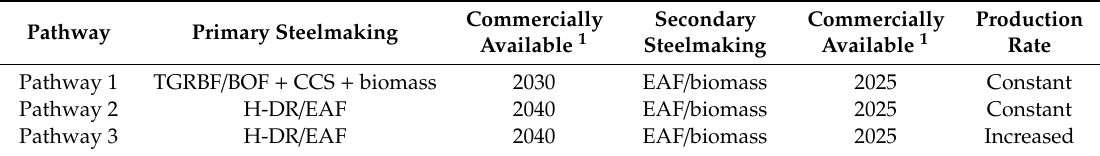
Overview of the process configurations as well as production rate assumption for pathways